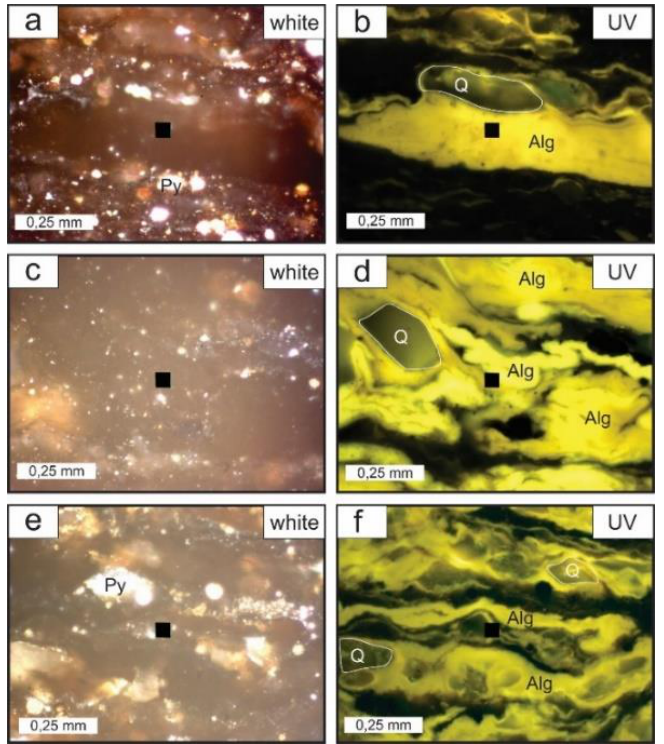
Figure 5. Photomicrographs illustrating a typical maceral composition of the alginite-rich layers. ( a , c , e ) Samples under reflected white light shows enrichment of organic matter in mineral matrix. Many colonies contain pyrite; ( b , d , f ) same samples under UV light shows high intensity yellow luminescence of alginite. Air, magnification of 50× for all photomicrographs. Alg, alginite; Q, quartz; Py, pyrite.